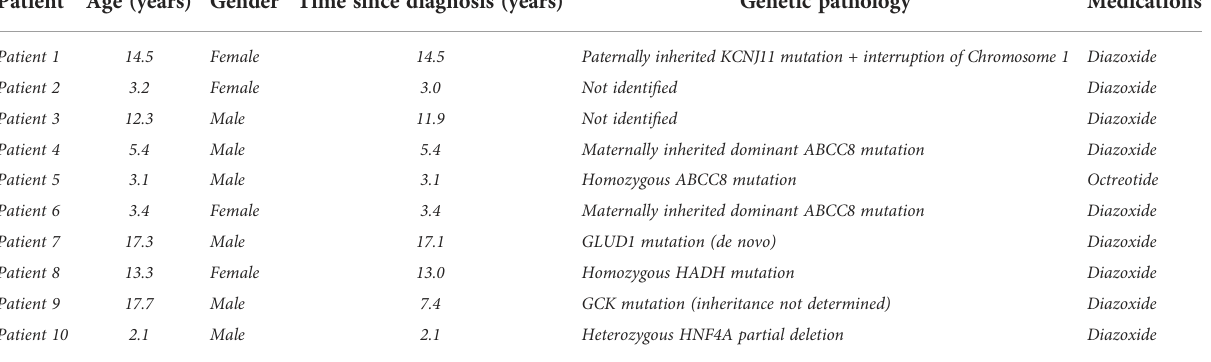
TABLE 1 Demographics and clinical details of all patients included in the study. Patient Age (years) Gender Time since diagnosis (years)